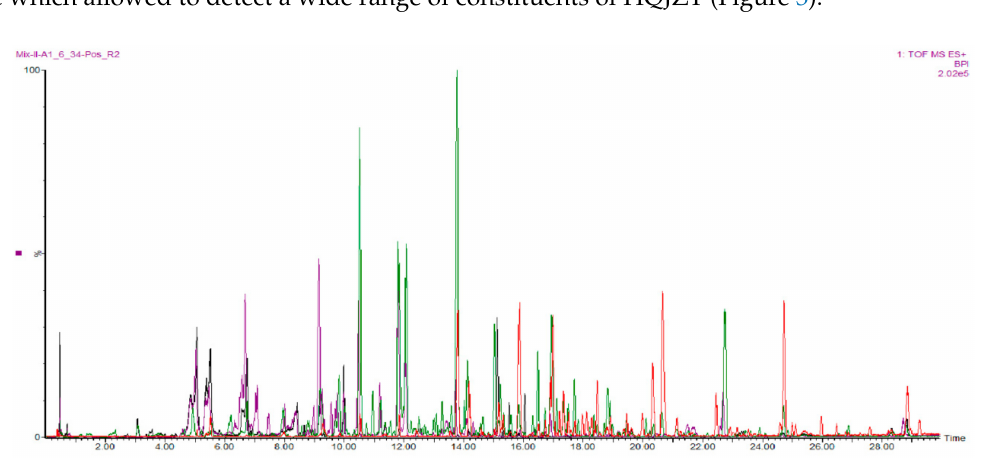
Figure 3. Base peak UPLC-QTOF-MS chromatograms of HQJZT fractions in ESI positive ion mode; red: n -hexane fraction, green: DCM fraction, violet: EtOAc fraction, black: n -BuOH